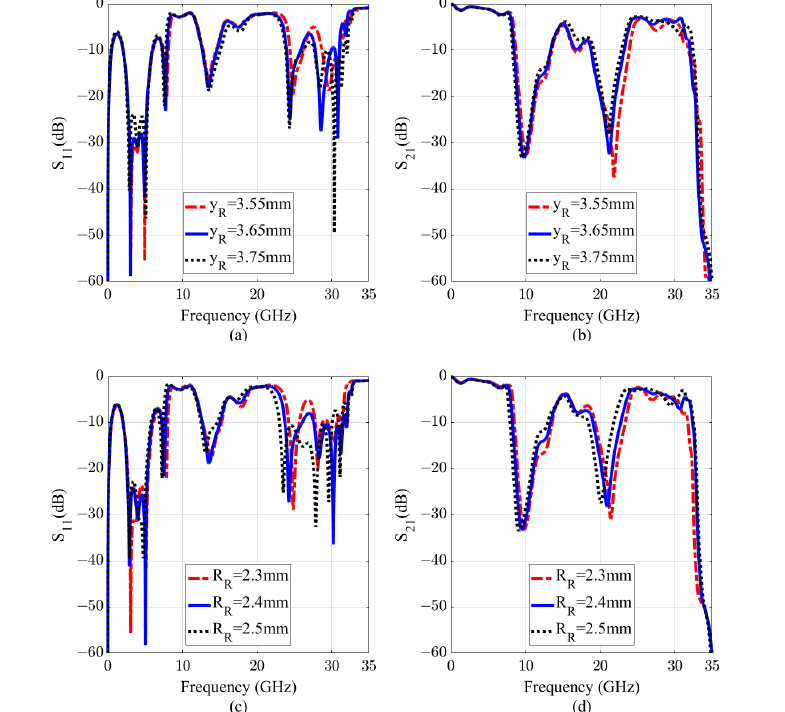
Figure 6. Scattering parameters of the D-BRF. ( a , b ) with different value of the CCRRs distance to the SSPP-TL ( y R ). ( c , d ) with change of the CCRRs radius ( R R